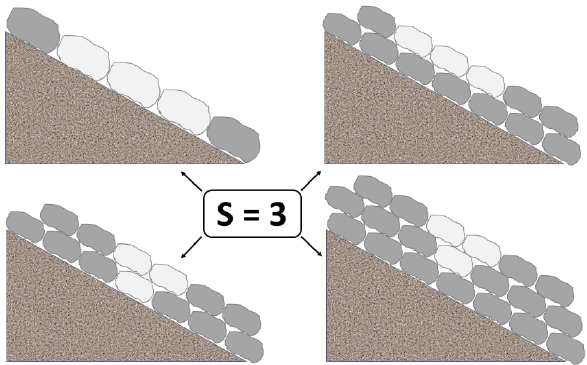
Figure 3. Various possible damage configurations with the same damage descriptor, S = 3. Adapted from Davies et al. [16].